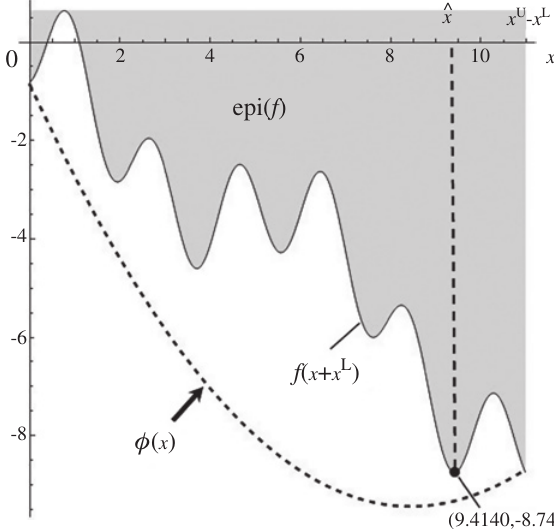
Figure 8: Trigonometric underestimator for a generalized polyno- mial